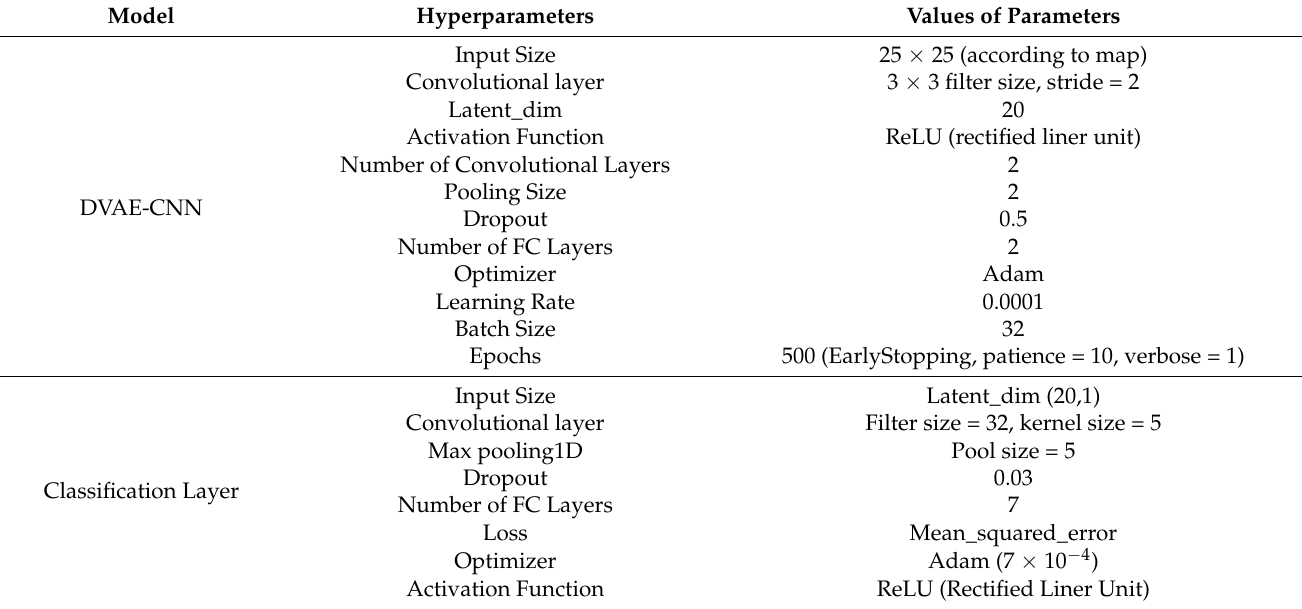
Table 1. Hyperparameters of the DVAE-CNN